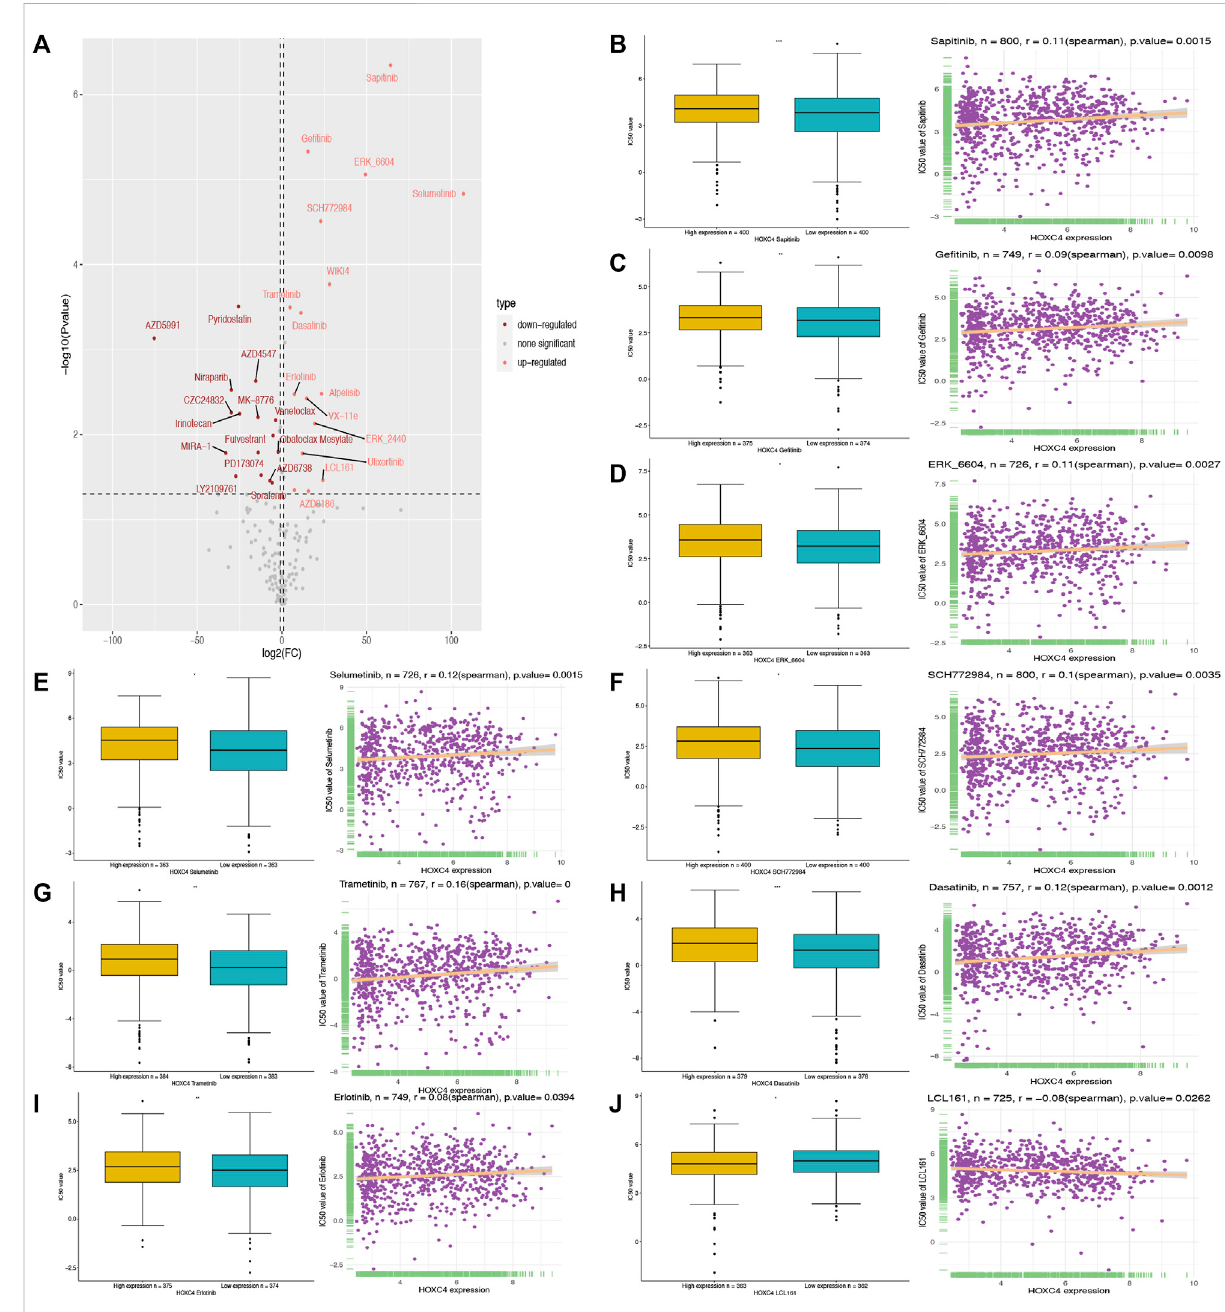
FIGURE 9 CorrelationanalysisbetweenHOXC4expressionandanti-cancerdrugsensitivityfromGSDC2dataset (A) volcanoplotvisualizesthecorrelation bewteen high-/low- HOXC4 expression group and different 1,050 values; (B – J) 1,050 values of 9 chemotherapy drugs show signi fi cant correlation with upregulated expression of